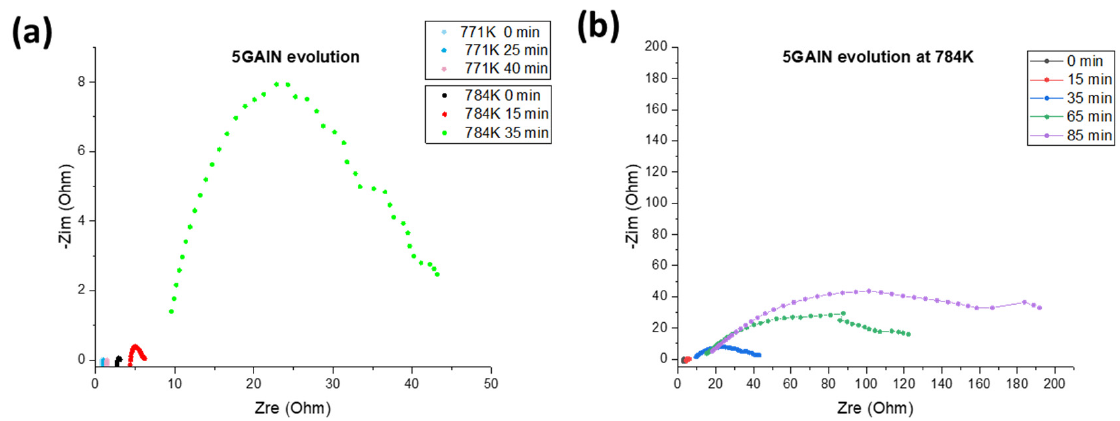
Figure 15. Evolution of the conductivity for 5 GAlN sample at ( a ) 771 K, ( b ) 784 K. Table 4. The conductivity of 5 GAlN composite at different temperatures and thermal evolution of conductivity at 771 K and 784